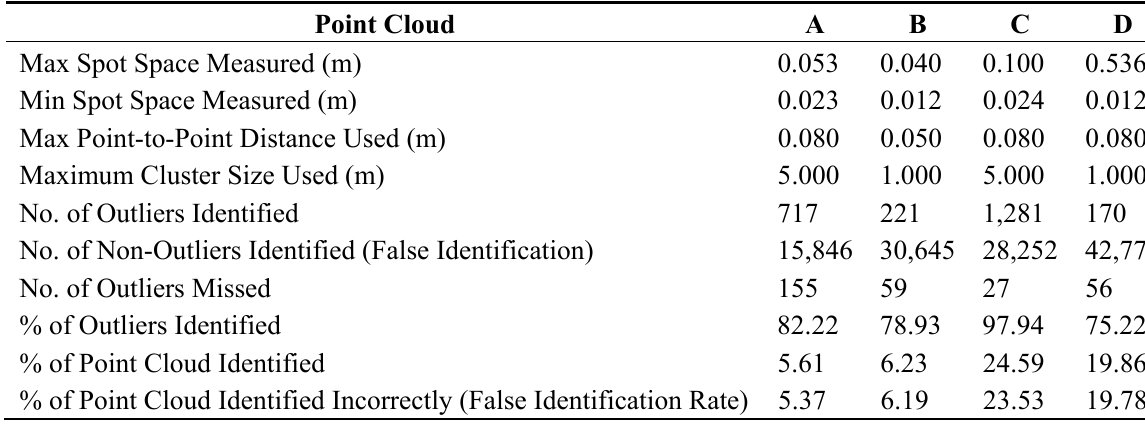
Table 7. Results from trials conducted using Polyworks IMSurvey’s (Version 11.0.30) Reject Outliers routine on point clouds A, B, C and